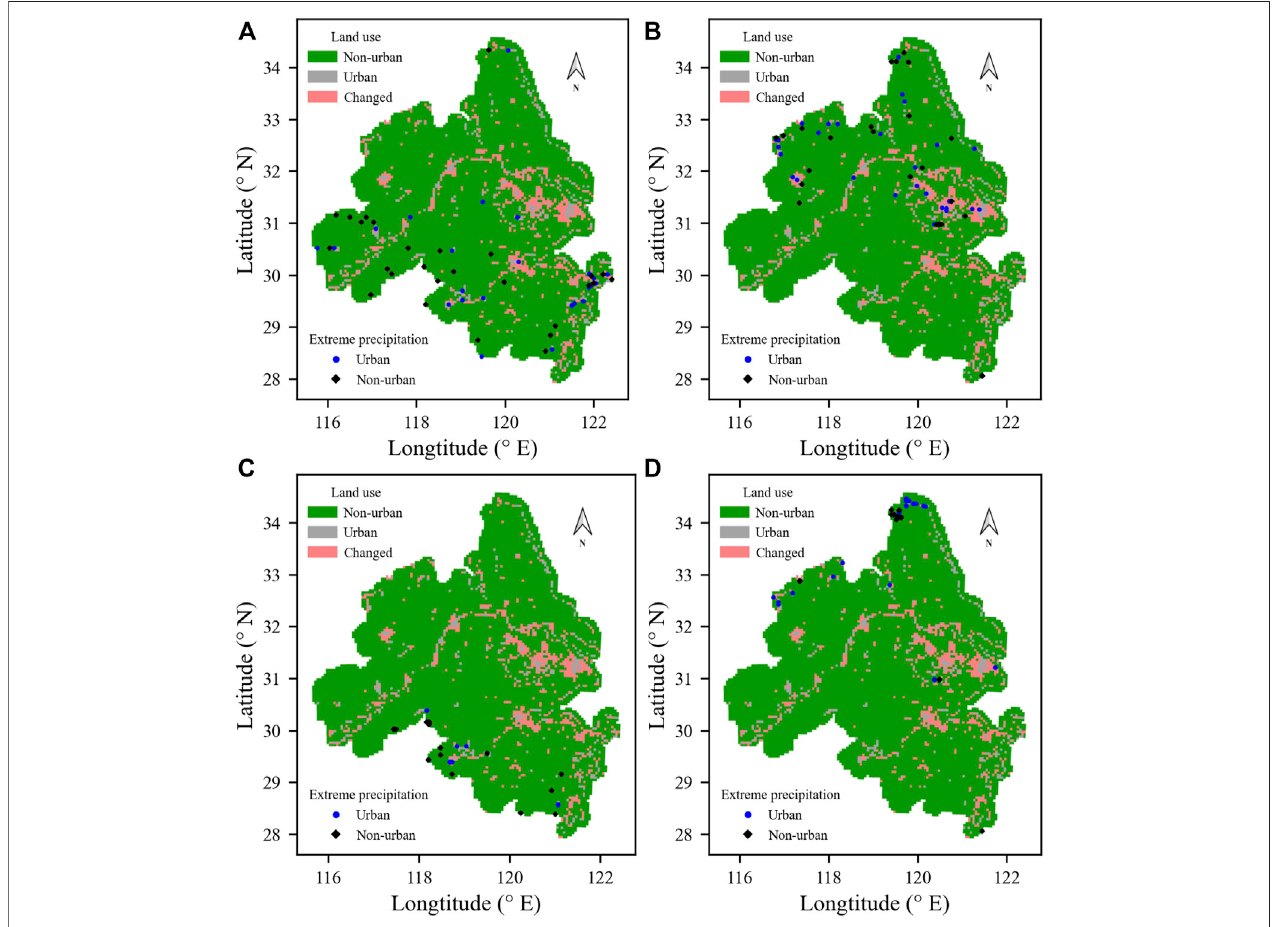
FIGURE 6 | The distribution of yearly precipitation extrema in the YDM from 1995 to 2020 for (A) maxima of MDP, (B) minima of MDP, (C) maxima of TP, and (D) minima of TP.